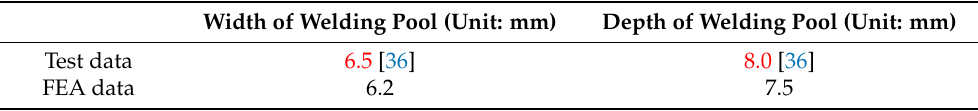
Figure 9. Welded pool model diagram (°C). Table 2. Comparison of welding pool parameters. Table 3. Welding heat source parameter. Width of Welding Pool (Unit: